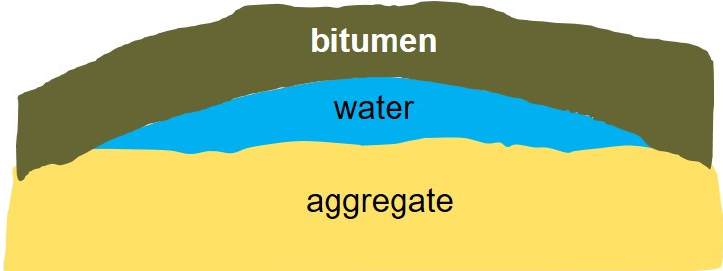
Figure 1. Adhesion failure at the aggregate-bitumen interface due to the penetration of water is termed “stripping”.